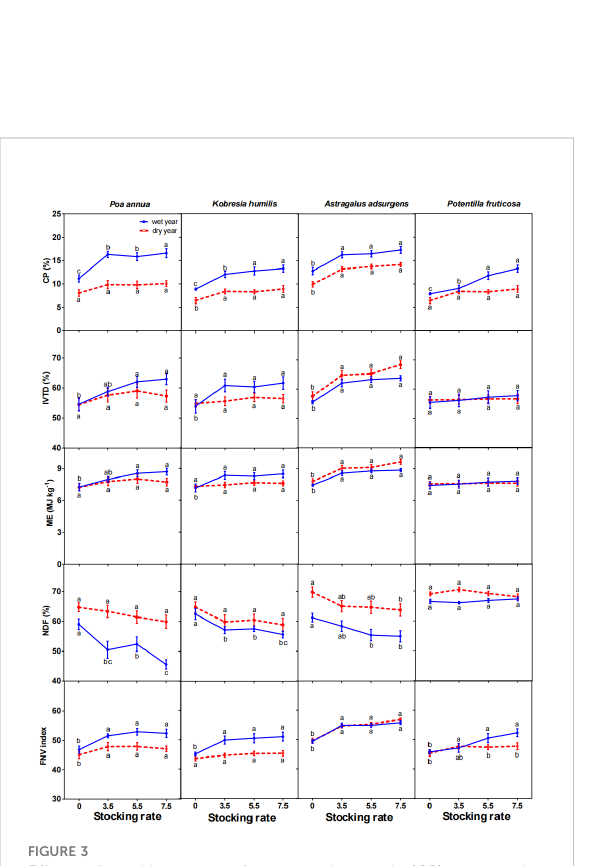
FIGURE 4 Effects of stocking rate on crude protein (CP) content, in vitro true digestibility (IVTD), metabolizable energy (ME), neutral detergent fi ber (NDF) content and forage nutritional value (FNV) of four dominant species in June, July, August and September (means ± standard error). Means with different letters in the same month differ from each other ( P<